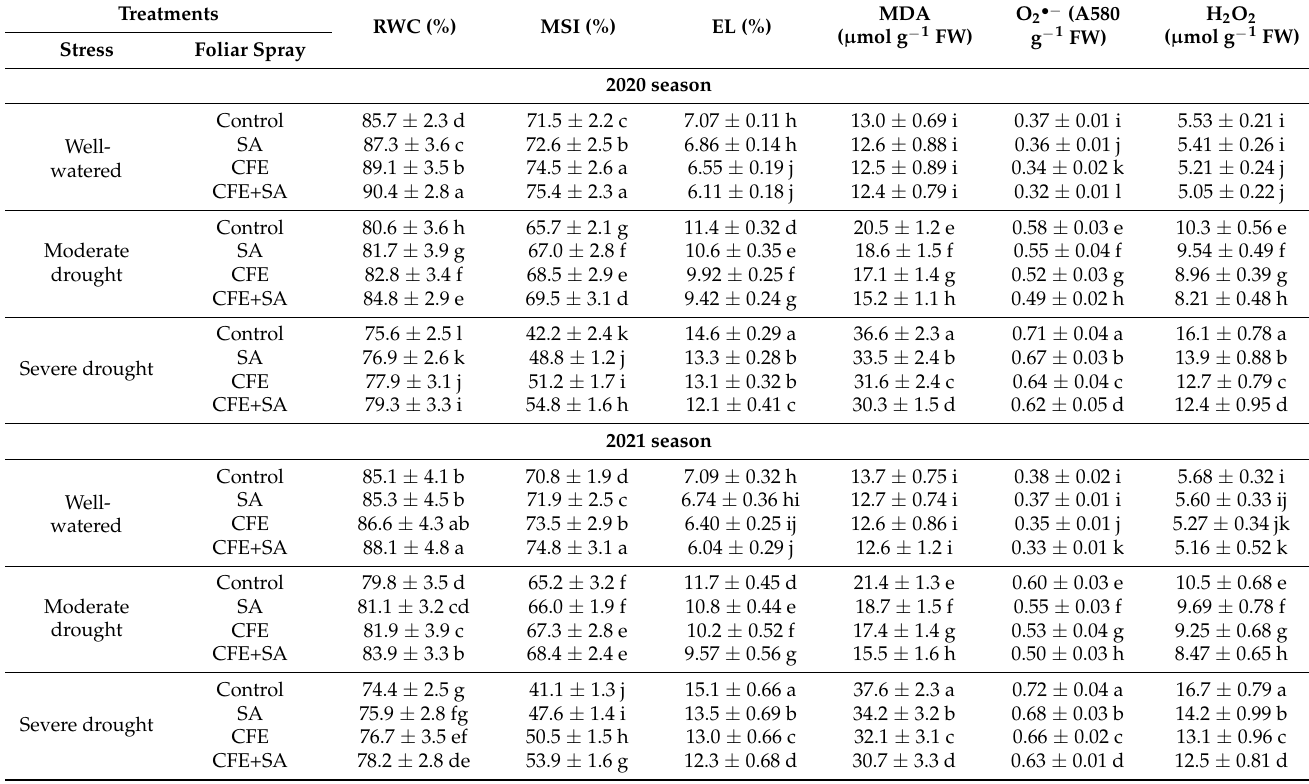
Mean values ( n = 9) in each column for each year, ± SE. Means were compared at p ≤ 0.05 by Duncan’s Multiple Range Test. Mean pairs followed by different letters are significantly different. Control plants were sprayed with distilled water vs CFE extract or CFE+SA for the other